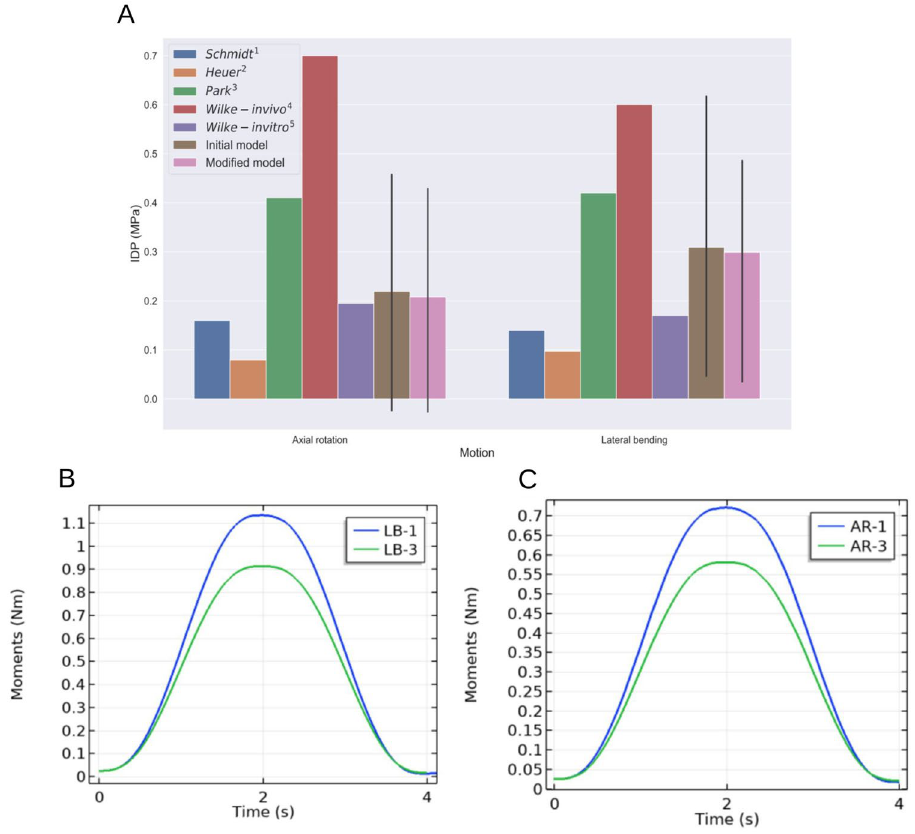
Figure 5. ( A ) Comparison of the predicted nucleus pressure with previous studies. (1) Schmidt et al., 2006 48 , (2) Heuer et al., 2006 49 , (3) Park et al., 2013 50 , (4) Wilke et al., 2001 51 , (5): Wilke et al., 1996 52 . ( B ) Total reaction moment over time during LB considering a static (LB-1) and a mobile (LB-3) ICR and using the initial geometry. ( C ) Total reaction moment over time during AR considering a static (AR-1) and a mobile (AR-3) ICR and using the initial